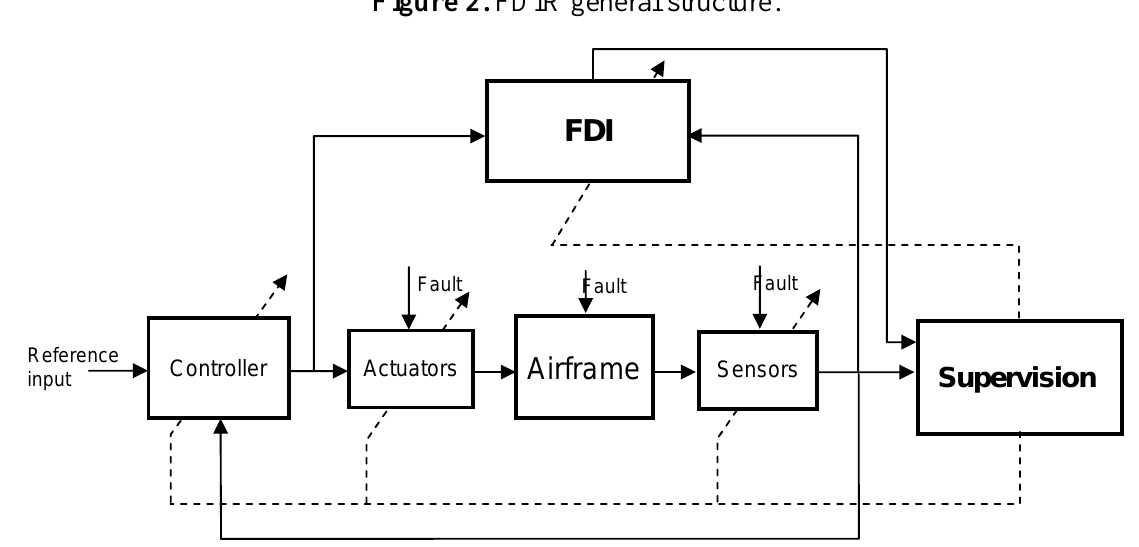
Figure 2. FDIR general structure.